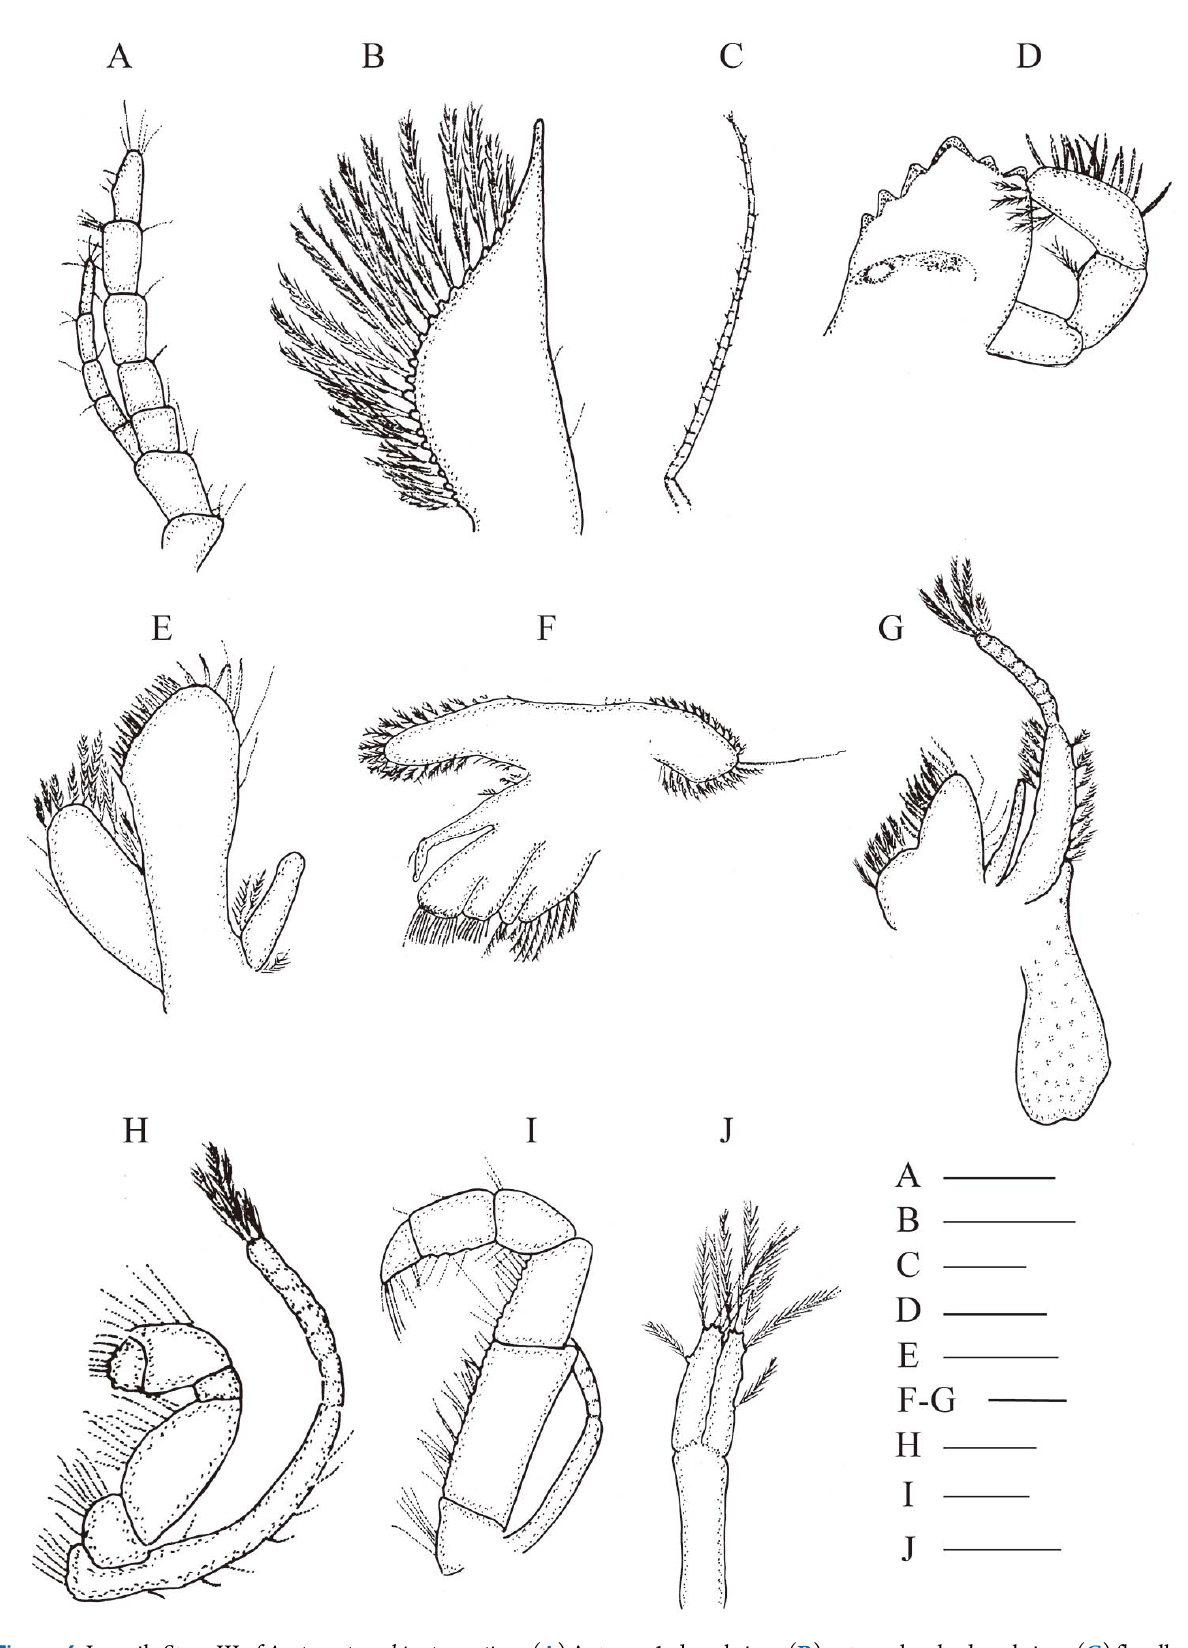
Figure 6. Juvenile Stage III of Austropotamobius torrentium . ( A ) Antenna 1, dorsal view; ( B ) antennal scale, dorsal view; ( C ) flagellum of antenna 2, dorsal view; ( D ) mandible, view of inside of mouth; ( E ) maxilla 1, oral view; ( F ) maxilla 2, oral view; ( G ) first maxilliped, oral view; ( H ) second maxilliped, oral view; ( I ) third maxilliped, oral view; ( J ) pleopod. Scale bars: 0.25 mm, C: 1.0